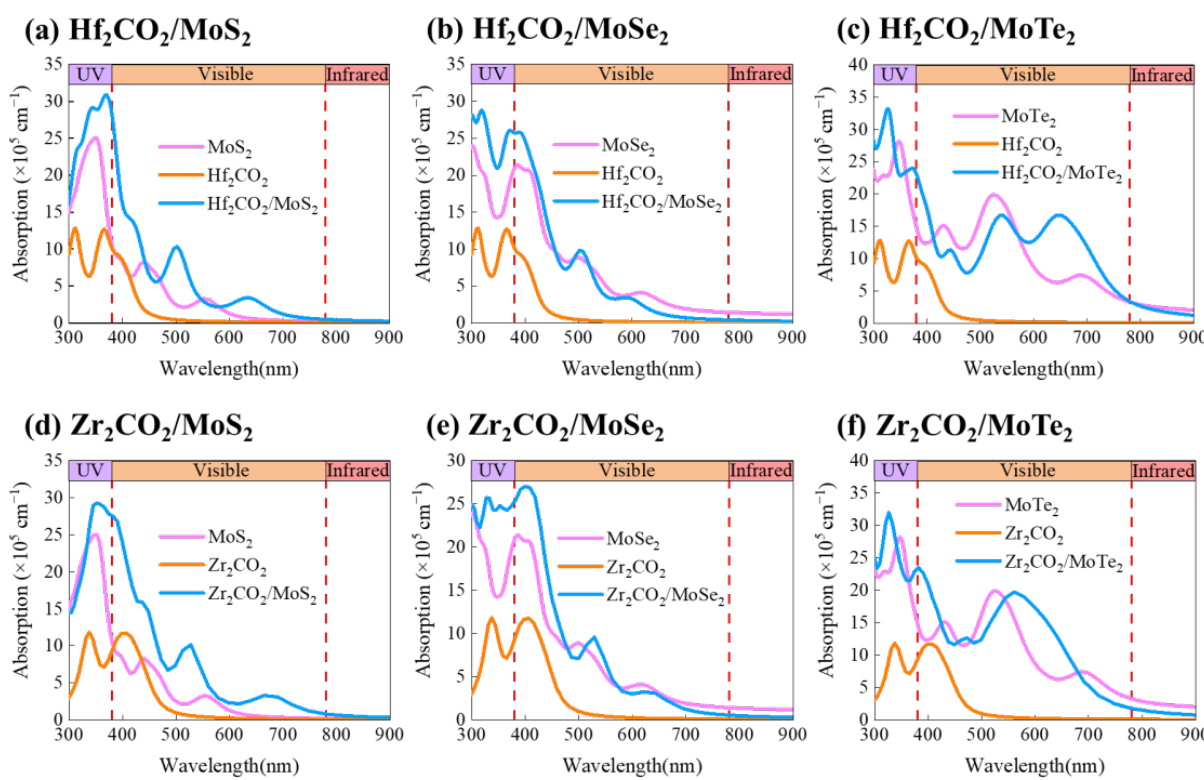
Figure 8. The absorption coefficient of ( a ) Hf 2 CO 2 /MoS 2 , ( b ) Hf 2 CO 2 /MoSe 2 , ( c ) Hf 2 CO 2 /MoTe 2 , ( d ) Zr 2 CO 2 /MoS 2 , ( e ) Zr 2 CO 2 /MoSe 2 , and ( f ) Zr 2 CO 2 /MoTe 2 heterostructures together with the pristine monolayers using HSE06 functional.